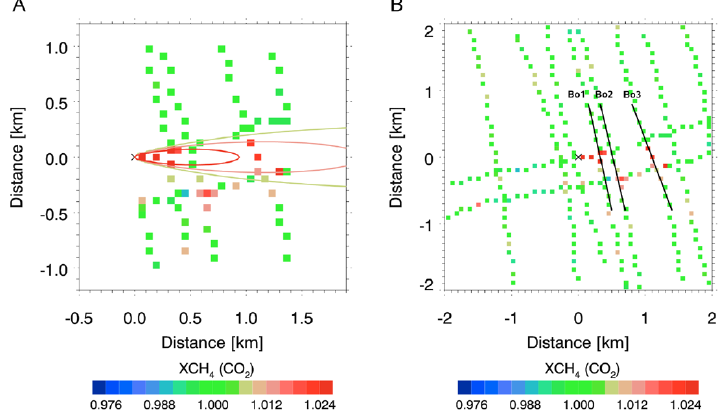
Fig. 11. Relevant data for the inversion of the emissions from Bockraden Shaft using the inverse Gaussian plume model (panel A ) and the integral method (panel B ). Contour lines (panel A ) indicate the result from the Gaussian plume model inversion, while the black tracks (panel B ) show the boundaries for the integral